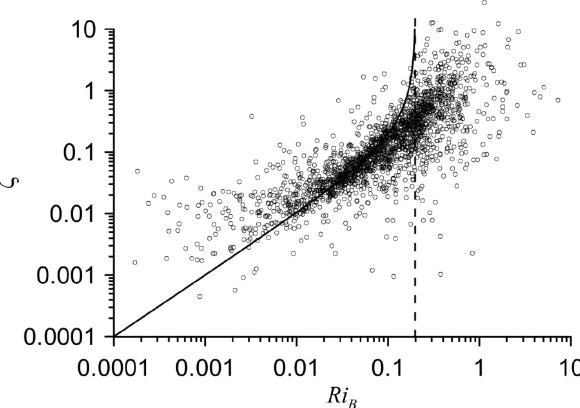
Fig. 3. Relationship between the two measures of overall stability – stability ς from bulk Richardson number Ri B – during the Indiana Figure 3. Relationship between the two measures of overall stability - stability ς from experiment. The critical Ri B (dashed line) and BDH relationship bulk Richardson number Ri B - during the Indiana experiment. The critical Ri B (dashed (empirically-derived values from Businger et al., 1971, Dyer, 1974 and Hicks, 1976) below critical Ri B (solid line) are indicated. line) and BDH relationship (empirically-derived values from Businger et al. (1971), Dyer (1974) and Hicks (1976)) below critical Ri B (solid line) are indicated.